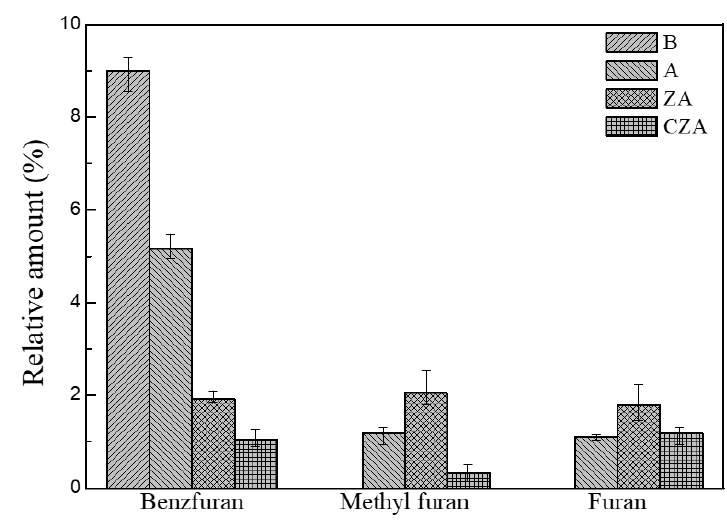
Figure 9. E ff ects of the catalysts on the furan compounds. Figure 9. Effects of the catalysts on the furan compounds.